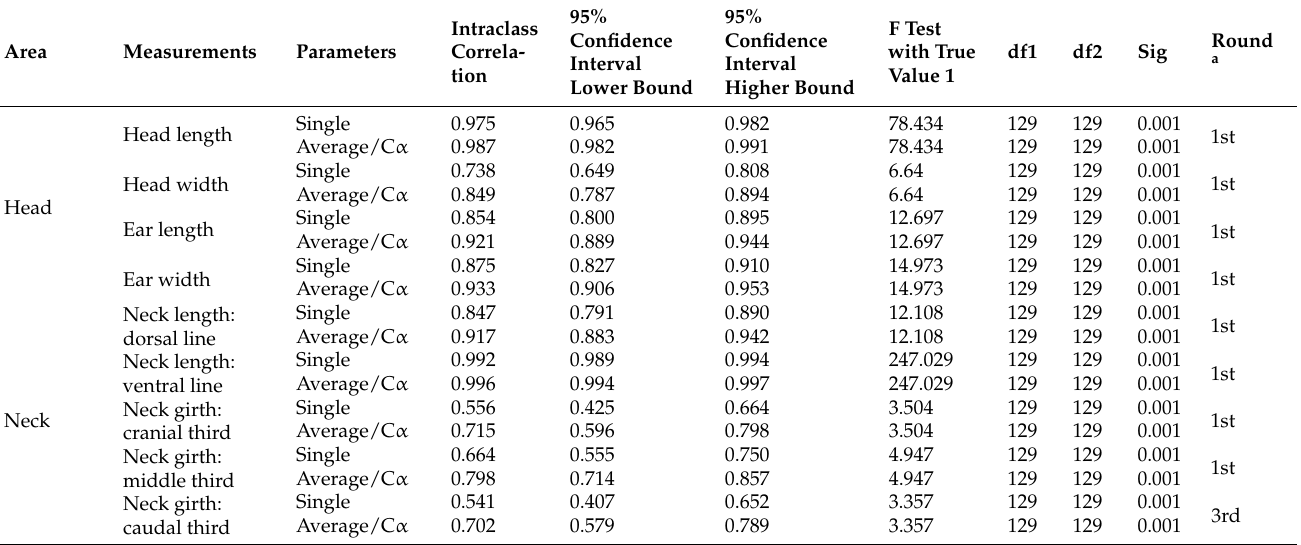
Table 2. Intraclass correlation coefficient (ICC) for single and average measurements (Cronbach’s alpha, C α ) comparison between on-field zoometrics and digital imaging